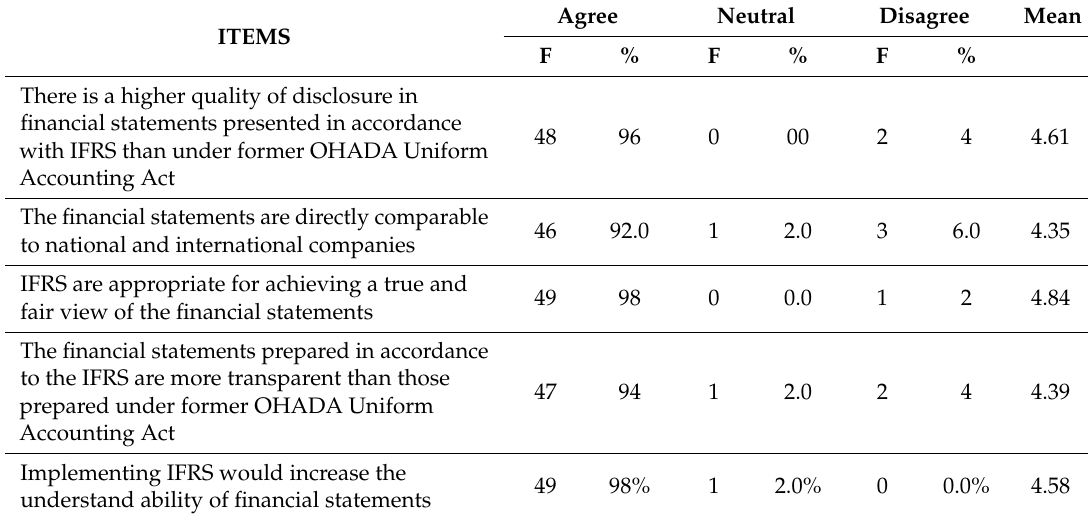
Table 2. Respondents’ views on comparability and transparency of financial